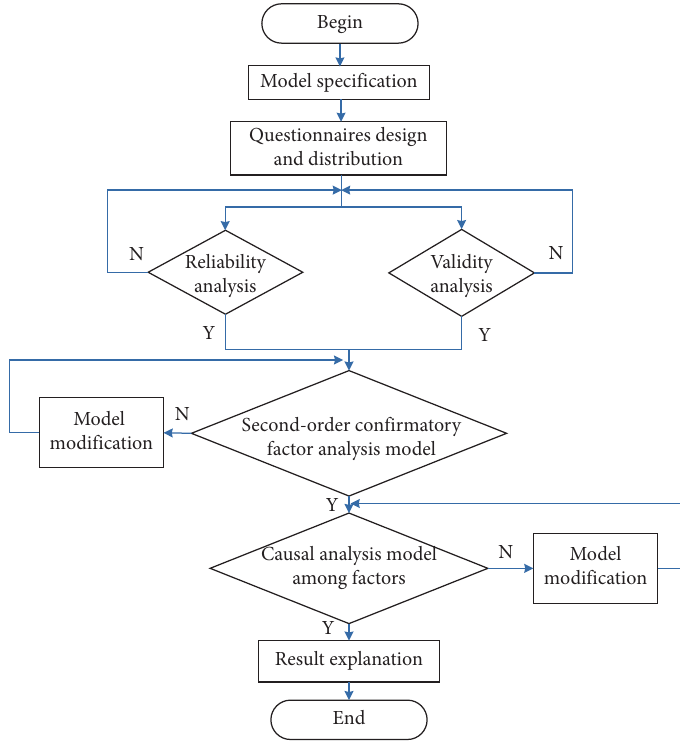
Figure 1: Flow chart of SEM. Table 1: Comprehensive benefit evaluation index of